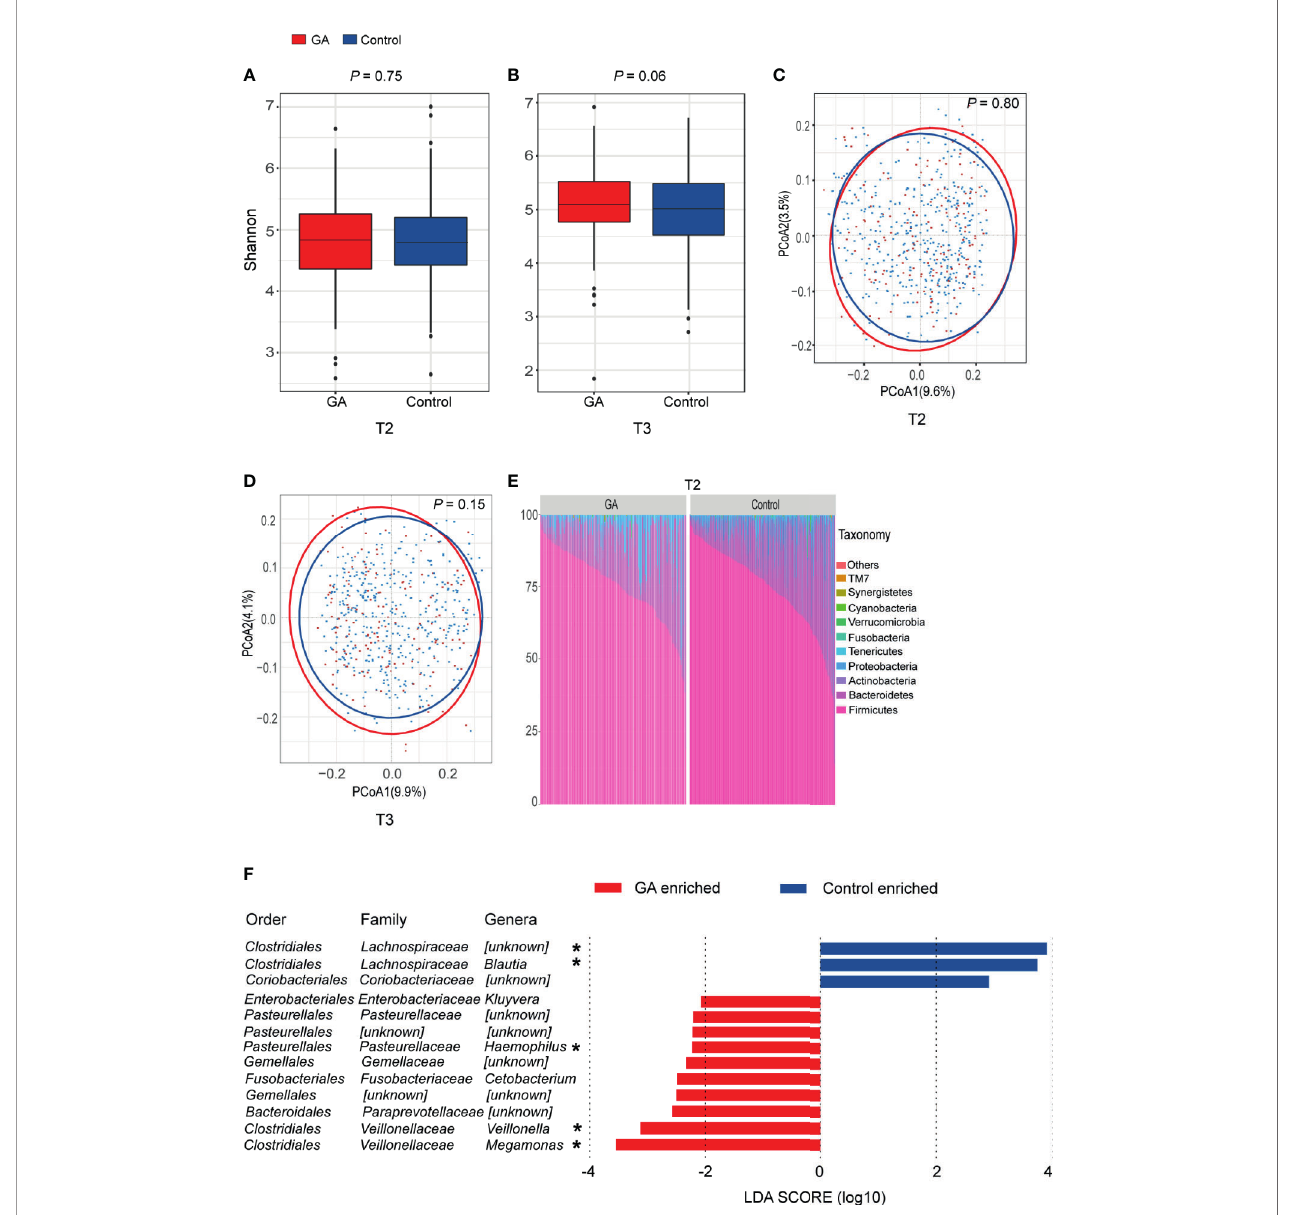
FIGURE 2 | Comparisons of alpha-diversity, beta-diversity, and variations of gut microbiota composition between GA and healthy control. (A) Box plots based on Shannon diversity index in the second trimester. (B) Box plots based on Shannon diversity index in the third trimester. (C) PCoA based on unweighted UniFrac matrix of T2 group. (D) PCoA based on unweighted UniFrac matrix of T3 group. (E) Relative proportions of bacterial phyla in GA and healthy control in the second trimester. (F) Histogram of the LDA scores computed for differentially abundant taxa between GA and healthy control in the second trimester (FDR < 0.05). FDR, false discovery rate; PCoA, principal coordinate analysis; GA, gestational anemia; T2, the second trimester; T3, the third trimester; LDA, linear discriminant analysis; *Genera remained signi fi cantly associated with GA after adjusting for covariates using multivariate association with linear models algorithm (MaAsLin). * P <